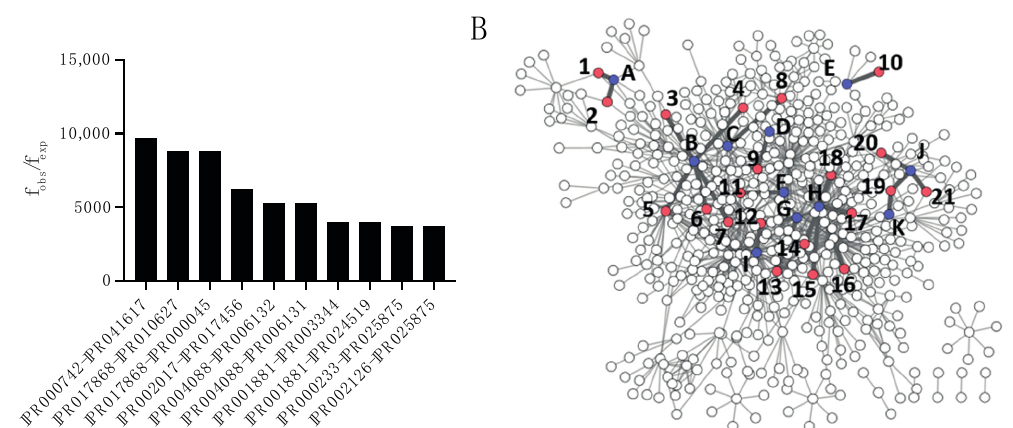
Figure 4. Analysis of domain–domain associations. ( A ) Bar graph representation of the 10 most enriched DD associations. ( B ) Network representation of the DD associations in the PHISTO dataset. Interactions highlighted in dark gray represent the enriched DD associations present in at least three interactions. Host proteins are identified by letters and bacterial proteins by numbers. More details on these proteins can be found in Table 1.